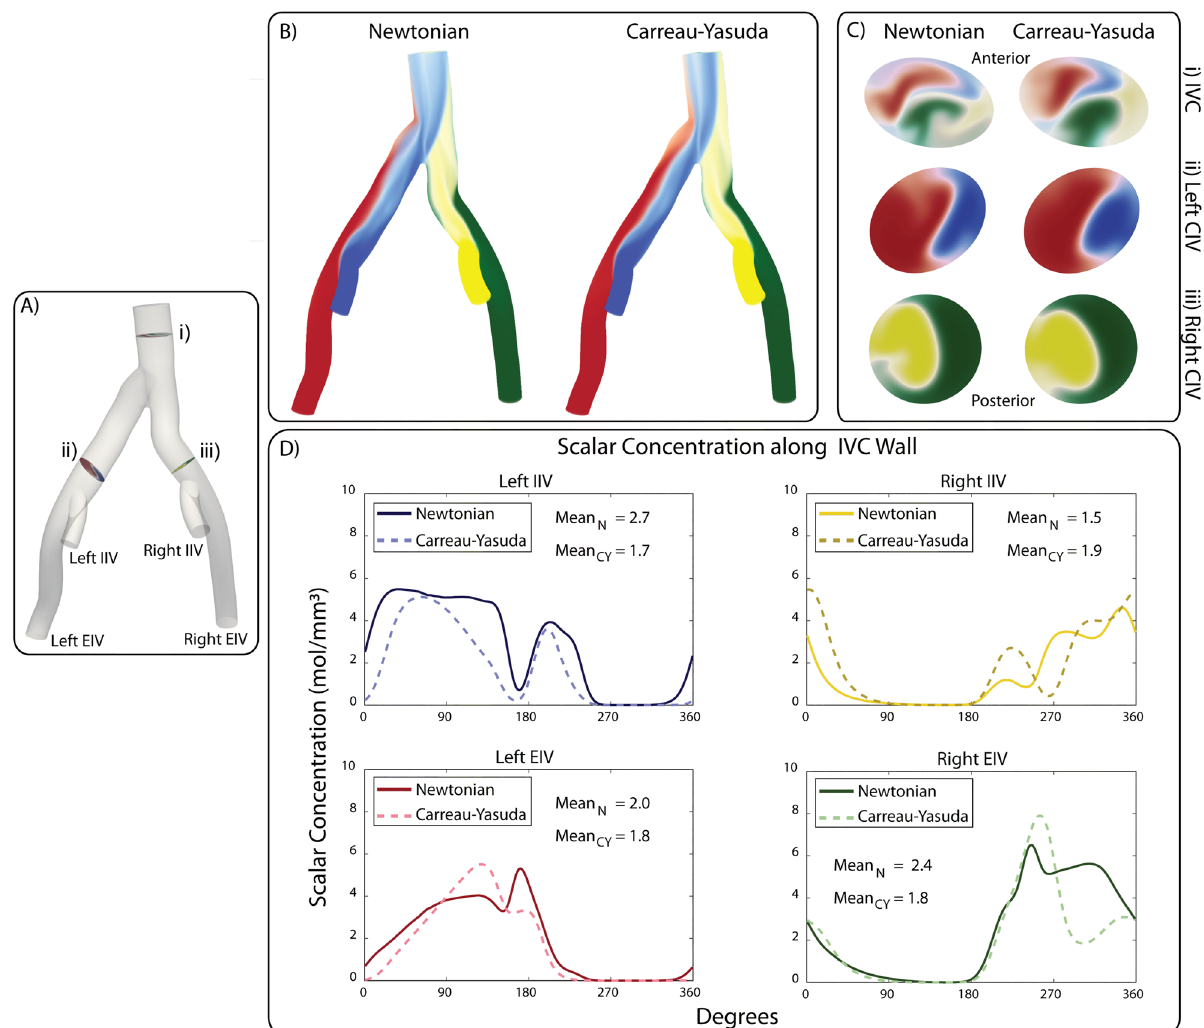
Figure 8. ( A ) Venous computational domain highlighting three locations (i–iii). ( B ) Volume rendering of the four scalar scalar fields for the Newtonian and non-Newtonian simulations. ( C ) Concentration contours of the four scalar fields at locations (i–iii). ( D ) Scalar concentration along the IVC wall for Newtonian and non- Newtonian simulations for each scalar species. All results after eight cardiac cycles (time t